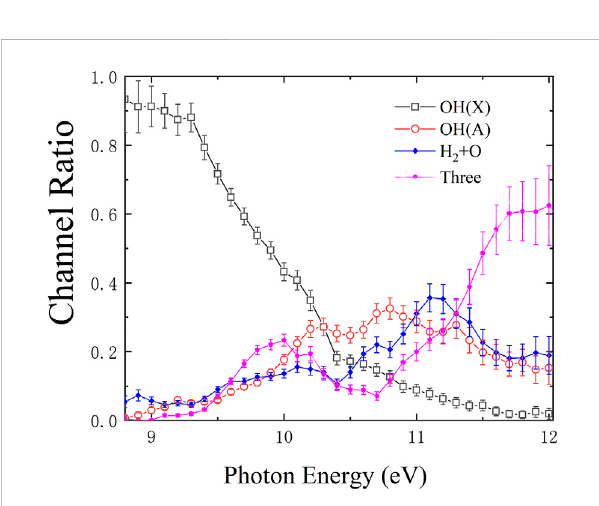
FIGURE 2 Branching ratio versus photon energy. OH(X) and OH(A) correspond to the H + OH channel with the OH fragment on ground and fi rstexcitedstates,respectively. “ Three ” correspondtotheH+H+ O channel. The error bars are determined from the statistical error of the number of the trajectories of each